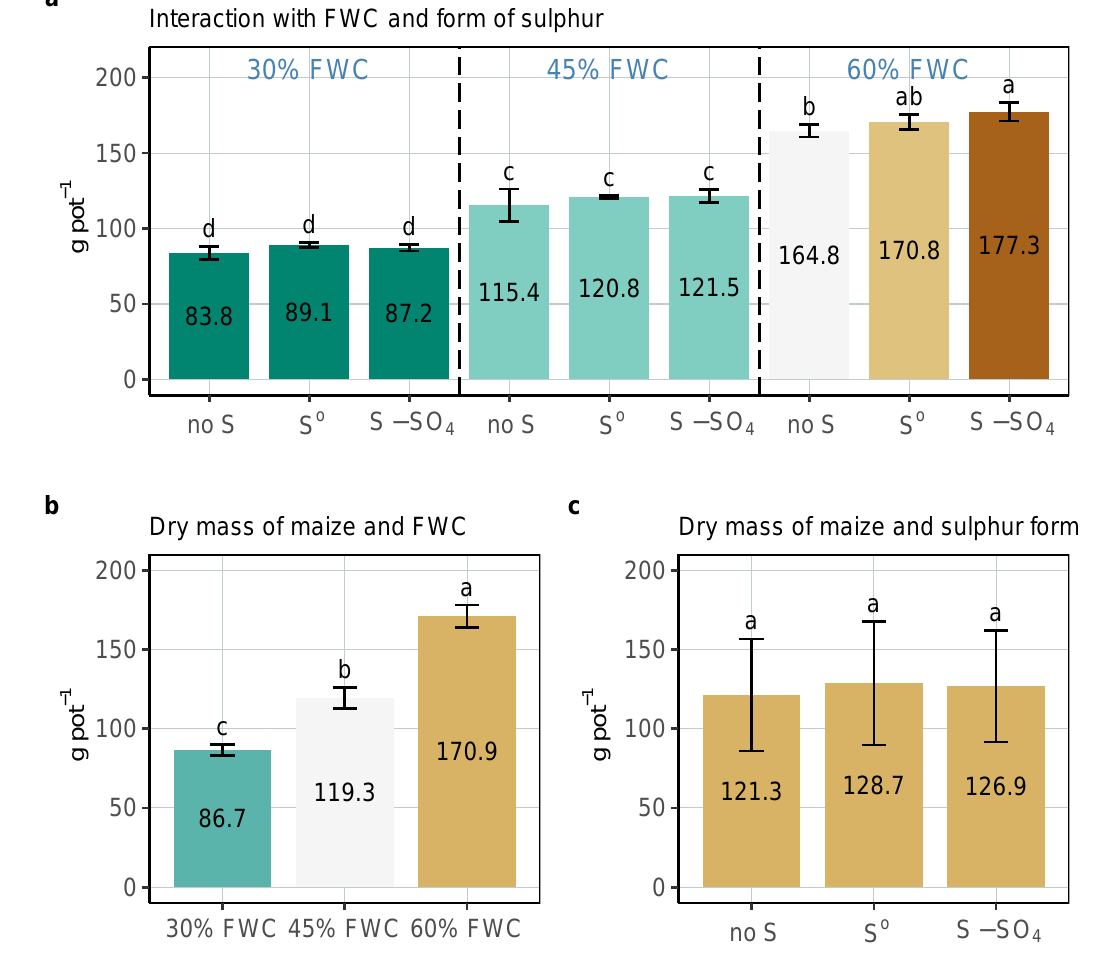
Figure 4. Dry mass yield of maize. Values indicated by the same letter are not significantly different ( α =